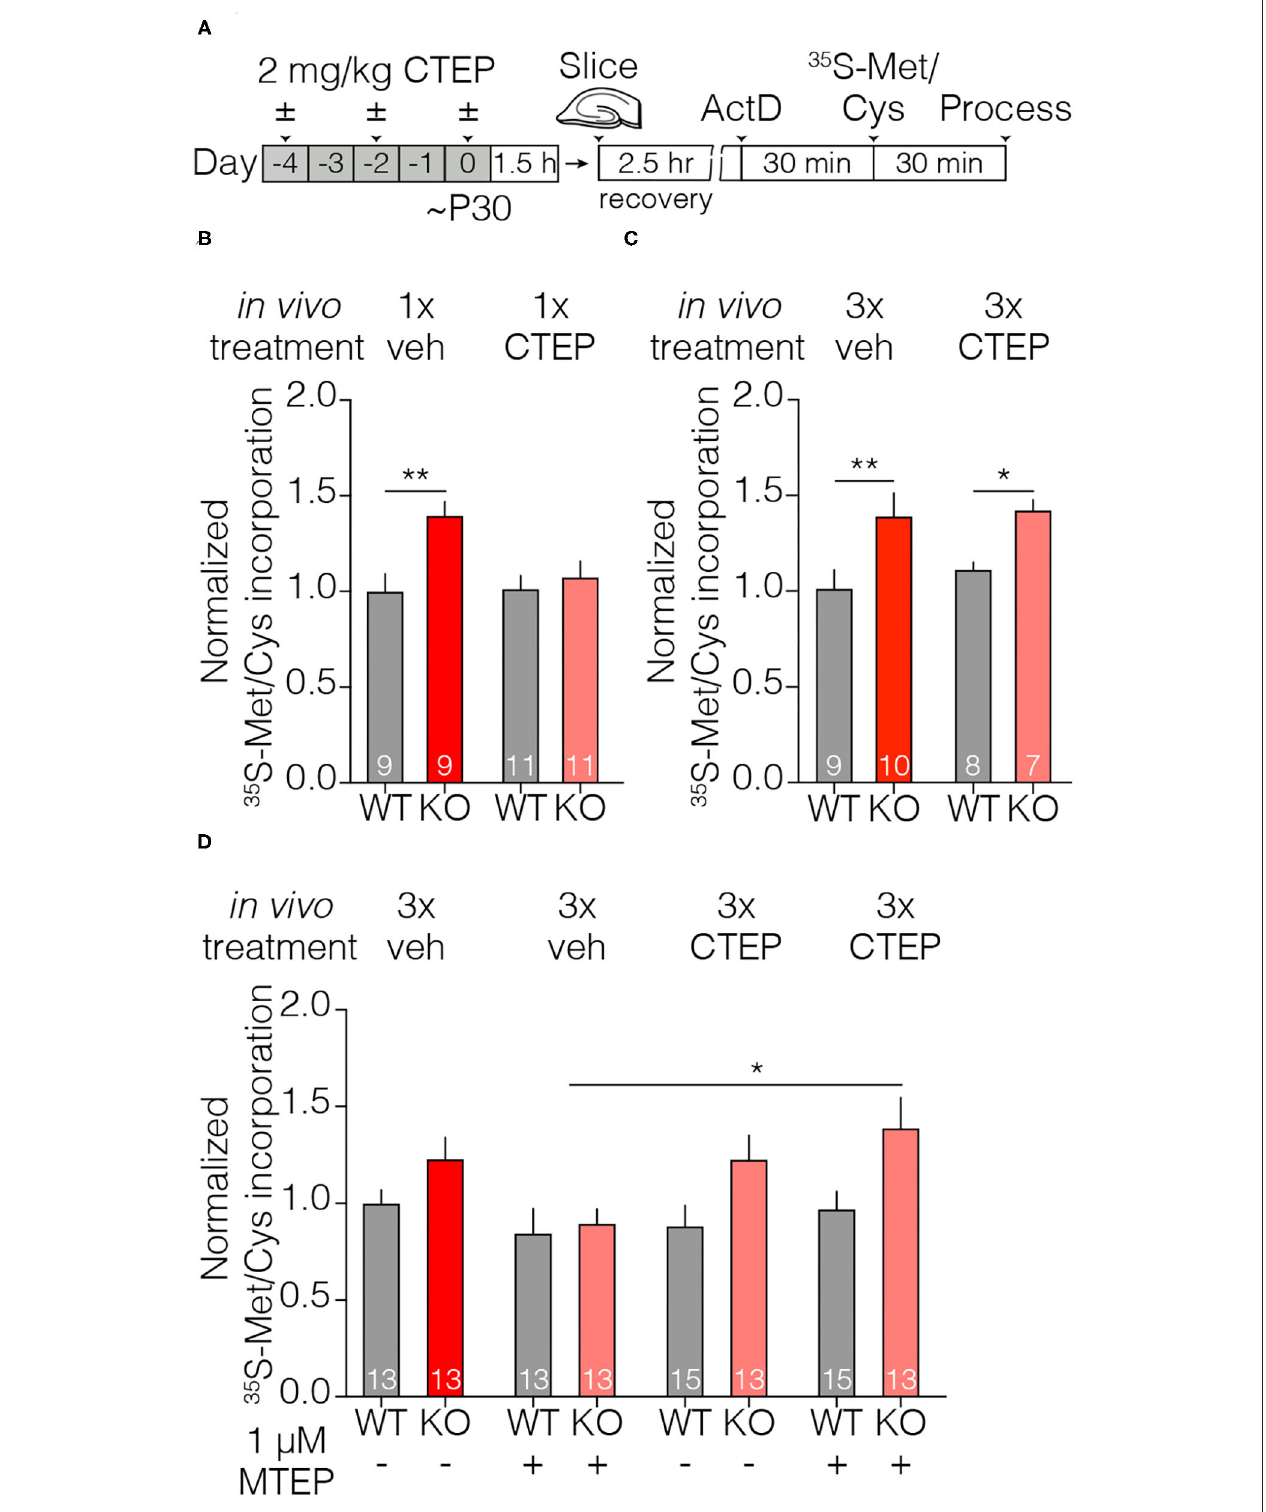
FIGURE 4 | Acute but not chronic CTEP treatment ameliorates elevated basal protein synthesis rates in Fmr1-KO hippocampal slices. (A) Schematic shows acute and chronic CTEP dose schedules and hippocampal metabolic labeling experimental design. (B) Basal protein synthesis rates are increased in hippocampal slices prepared from Fmr1-KO mice compared to wildtype littermate animals and acute in vivo treatment with 2 mg/kg CTEP restores Fmr1-KO protein synthesis rates to wildtype levels. There was a statistically significant effect of genotype [two-way ANOVA, F (1,36) = 8.341, p = 0.0066] and a significant interaction between